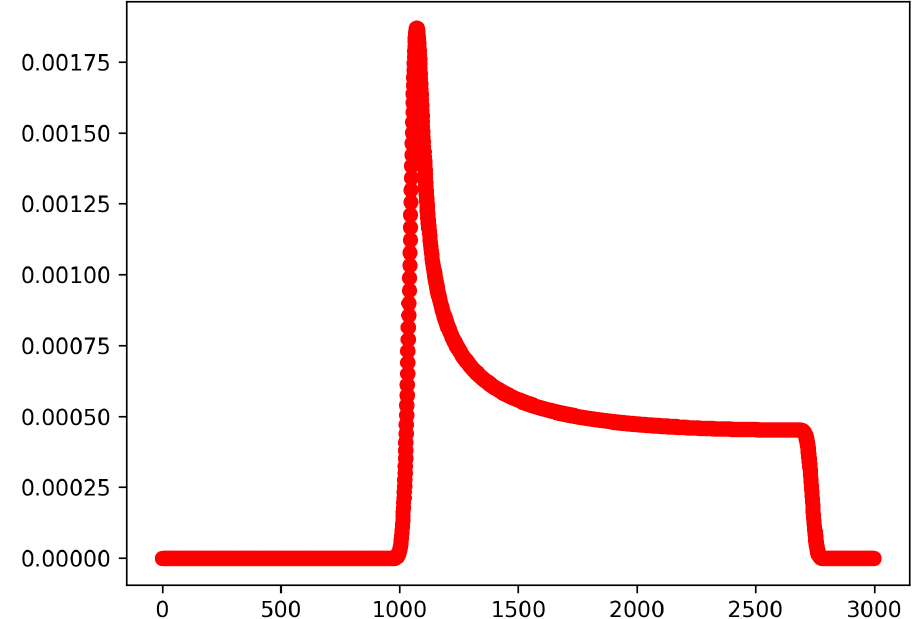
Figure 4. The exact degree distribution of the IRG generated by the biased static edge voting model with Range ( 3000 ) parametrization.